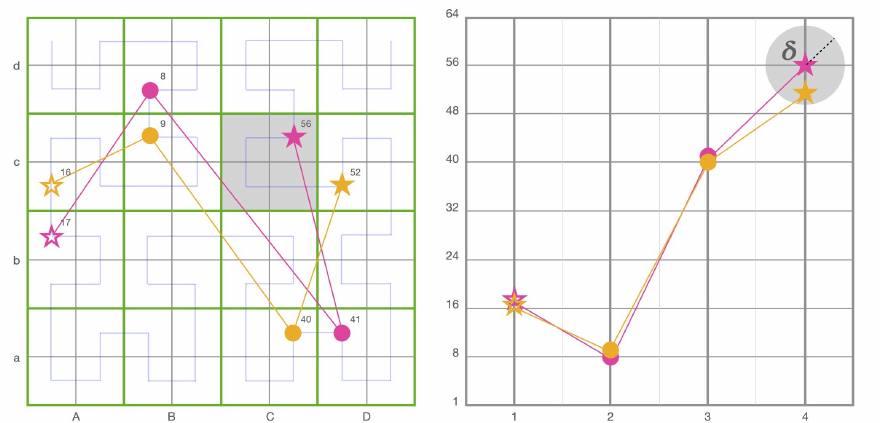
Figure 6. String editing quantisation methods introduce artefacts where points, depicted here as pink and orange, may be close together in Cartesian space but are far apart when quantised in the green grid. In our method, 1D Hilbert distances are quantised within the parameter δ originating from each point’s spatio-temporal position when calculating the discrete Fréchet distance, as illustrated using the fourth pink point in the diagram ( right ). Conversely, grid methods shown ( left ) quantised to enclosing green squares are prone to quantisation limitations, as shown in the diagram ( left ), where pink point Cc and orange point Dc are quantised apart even though they are close together. It should be noted that even though quantisation is reduced using this method, it is not completely removed, as demonstrated by the distance between points Bc and Cd. Start and end fixation are represented with (cid:73) and (cid:72) , respectively. String editing versus Hilbert distance are shown on an 8 × 8 grid quantised to 4 × 4.